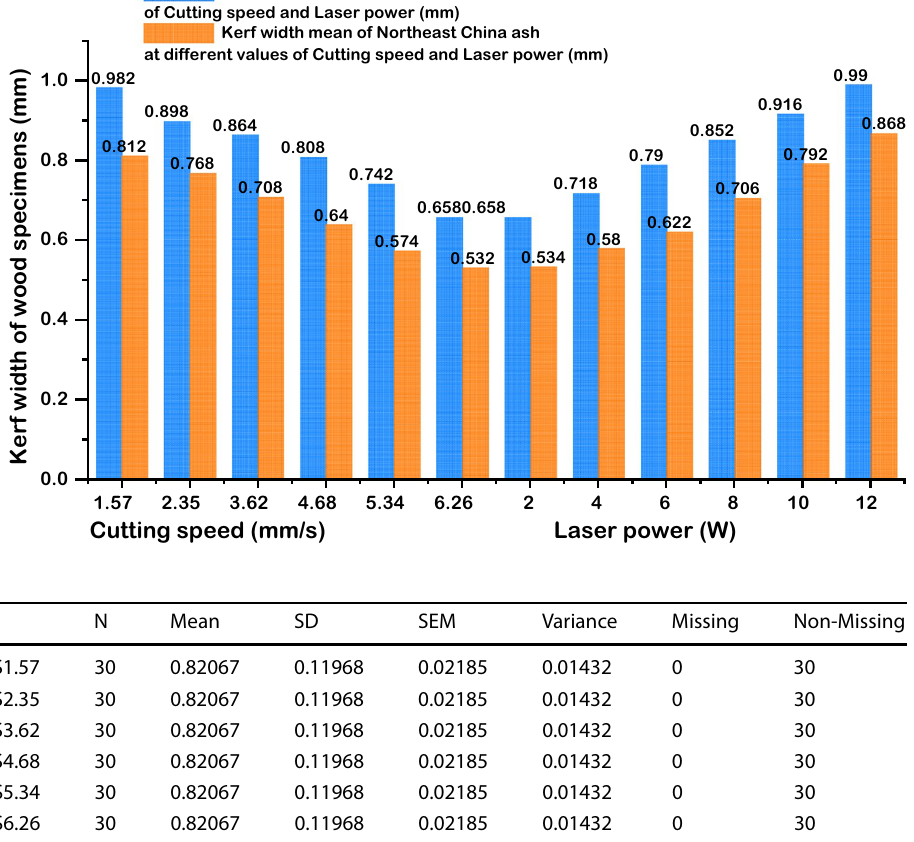
Fig. 17 Kerf width of the two wood specimens as a function of laser cutting speed and laser power